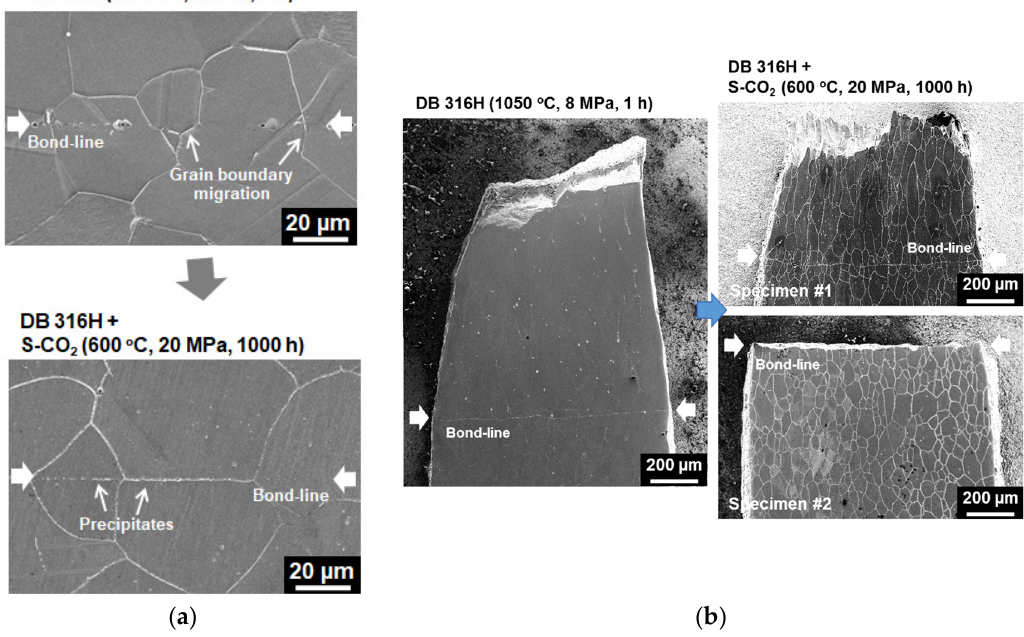
Figure 10. SEM micrographs of ( a ) diffusion bonded joint and ( b ) tensile ‐ tested specimens of diffusion bonded SS 316H before and after S ‐ CO 2 exposure at 600 °C (20 MPa) for 1000 h.